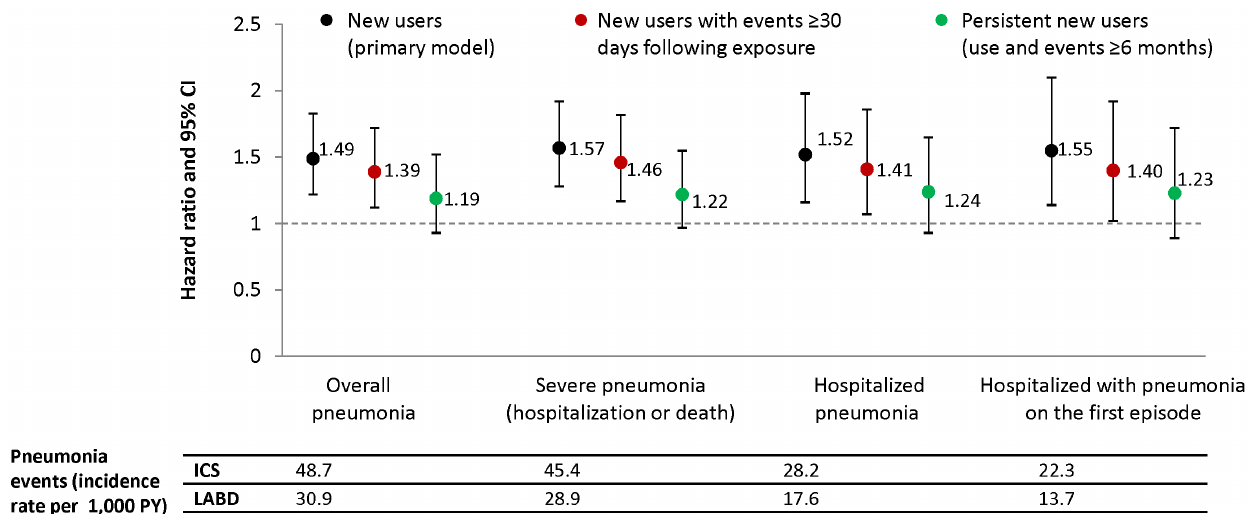
Figure 2. Pneumonia by different definitions among new users of ICS-containing and LABD medications (primary and sensitivity models). Data are hazard ratios and 95% CI for ICS compared with LABD. The incidence rates of pneumonia events per 1,000 person years for each group are presented below the figure for the primary model only. ICS: inhaled corticosteroid; LABD: long-acting bronchodilator.